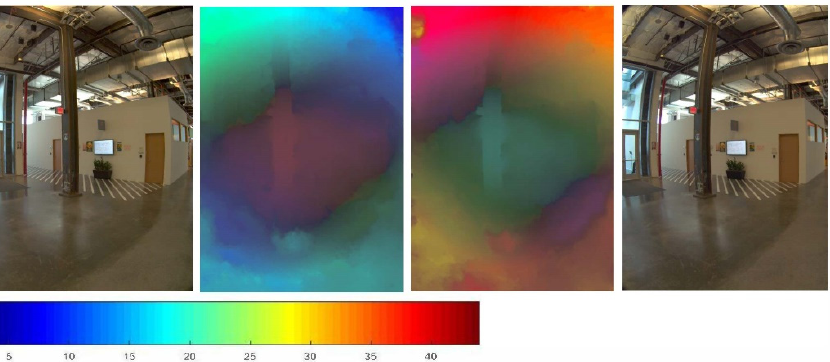
Figure 4. The optical flow approximates the inverse depth of the scene. A color bar of the optical flow field is shown below, and the value represents disparity in the x direction. flow field is shown below, and the value represents disparity in the x